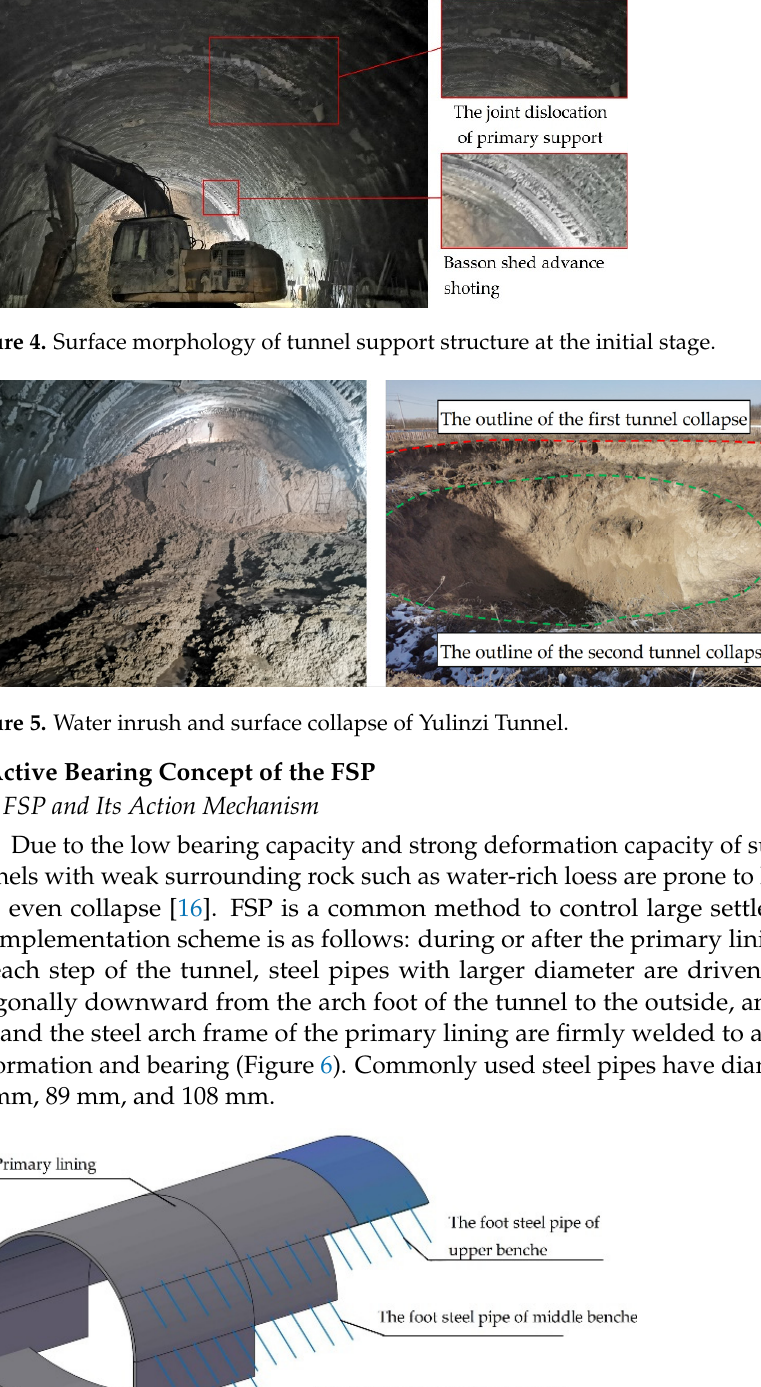
Figure 7. Elastic foundation beam model of foot steel pipe bearing. Figure 8. Simulation of deformation characteristics of vertical bearing capacity of foot steel pipe end. Figure 9. Simulated stress deformation curve of steel pipe under end load.